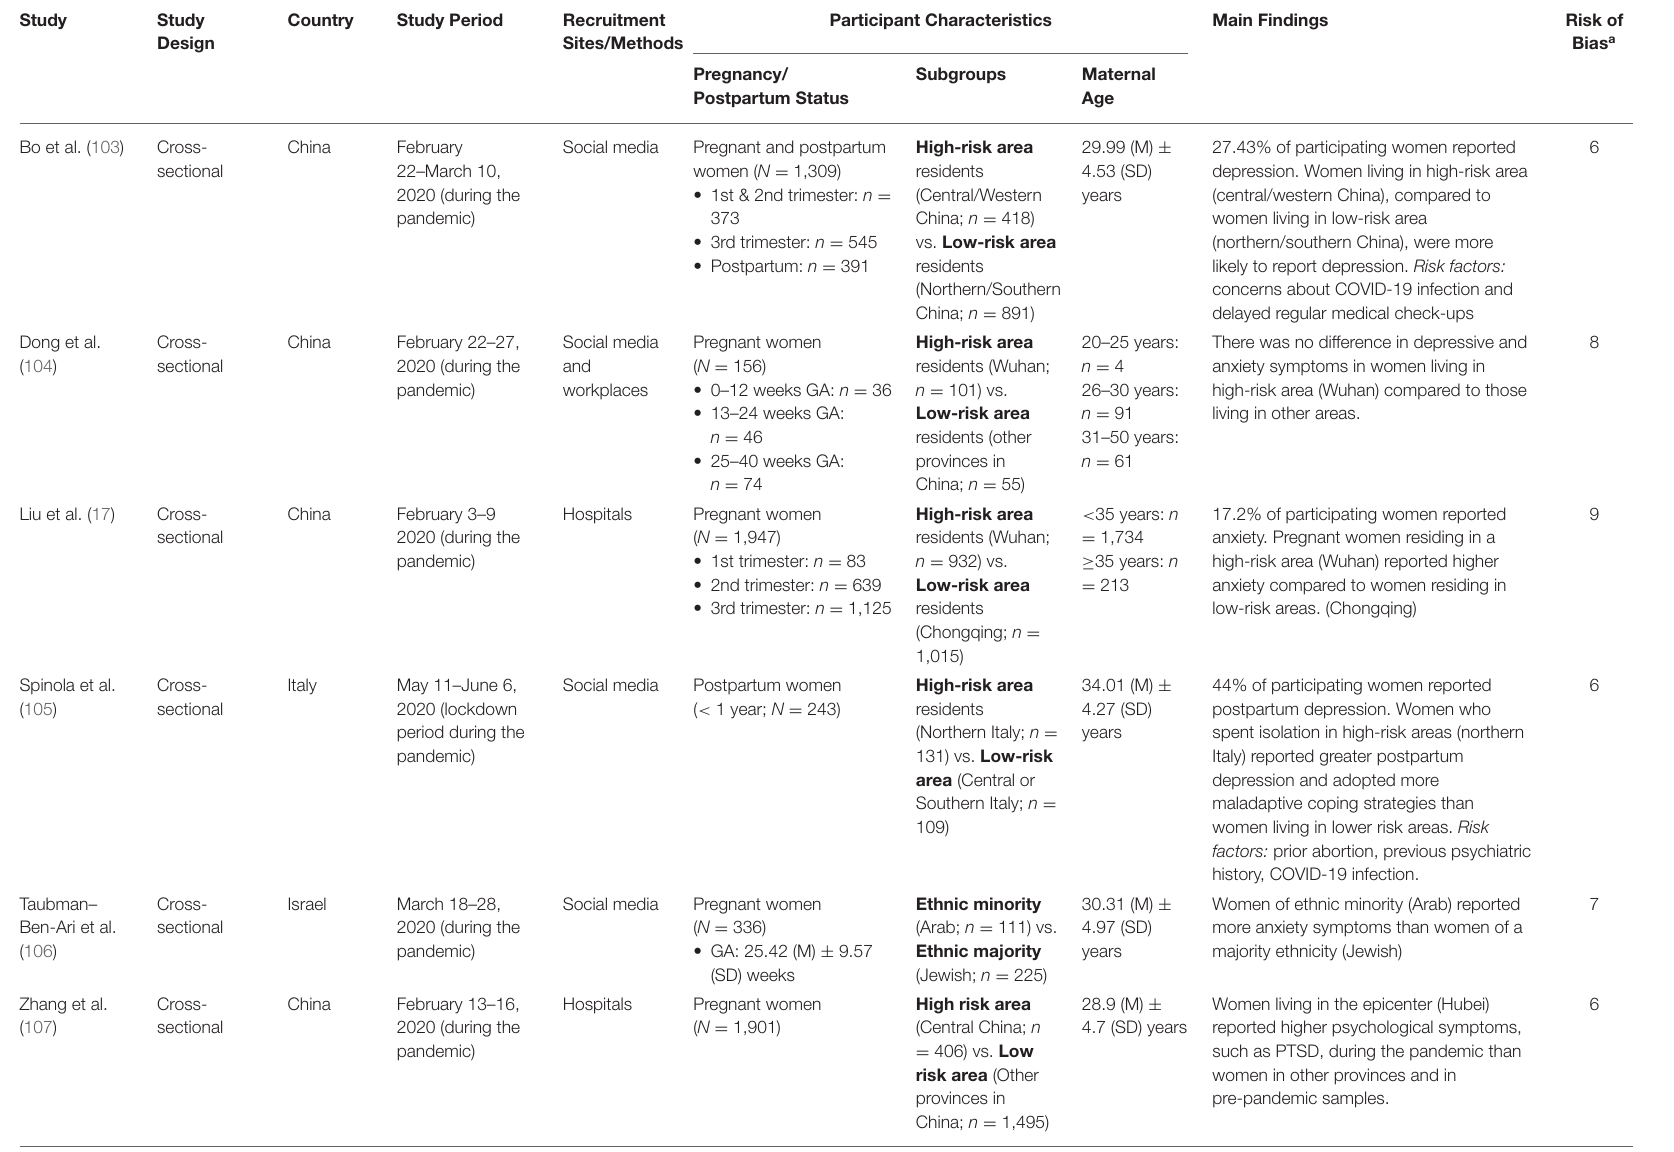
TABLE 6 | Perinatal mental health outcomes during COVID-19 as a function of cultural or geographic